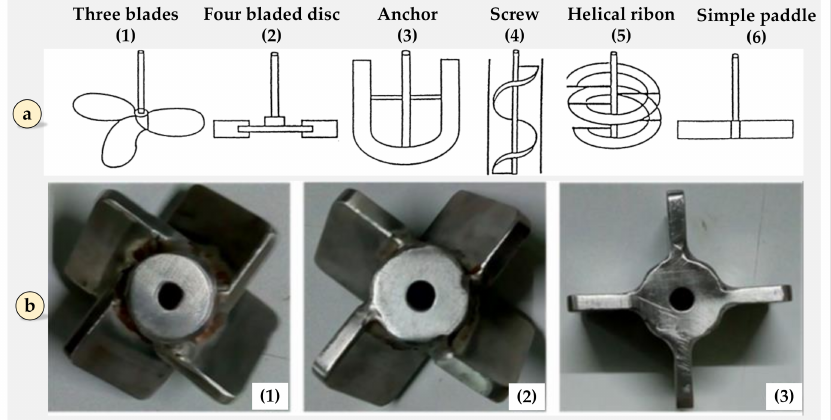
Figure 5. ( a ) Different types of stirring impellers, ( b ) the different angles of stirrer blade with (1) 45 ◦ , (2) 60 ◦ and (3) 90 ◦ reproduced from [84], with permission of Springer,